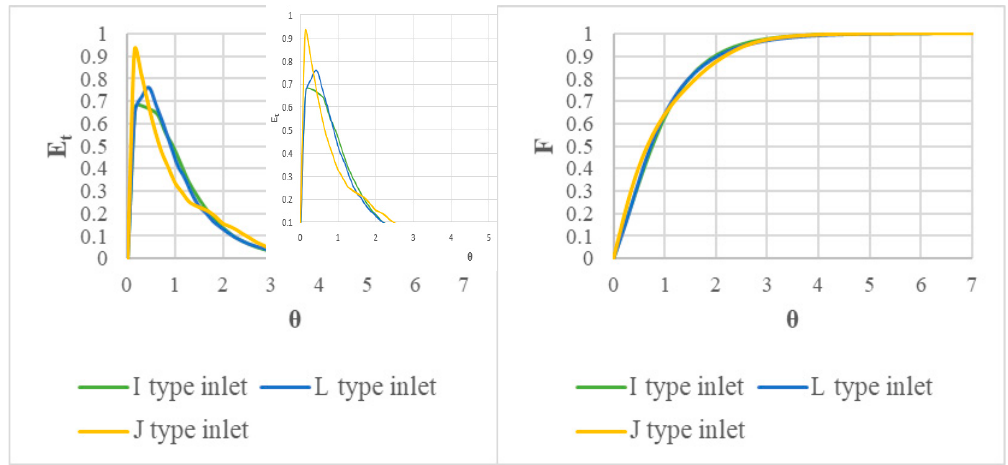
Figure 4. Residence time distribution (RTD) and cumulative RTD for three inlet types (inflow rate 1.5 L/min, inlet at 0.25 H, outlet at 0.33 H).